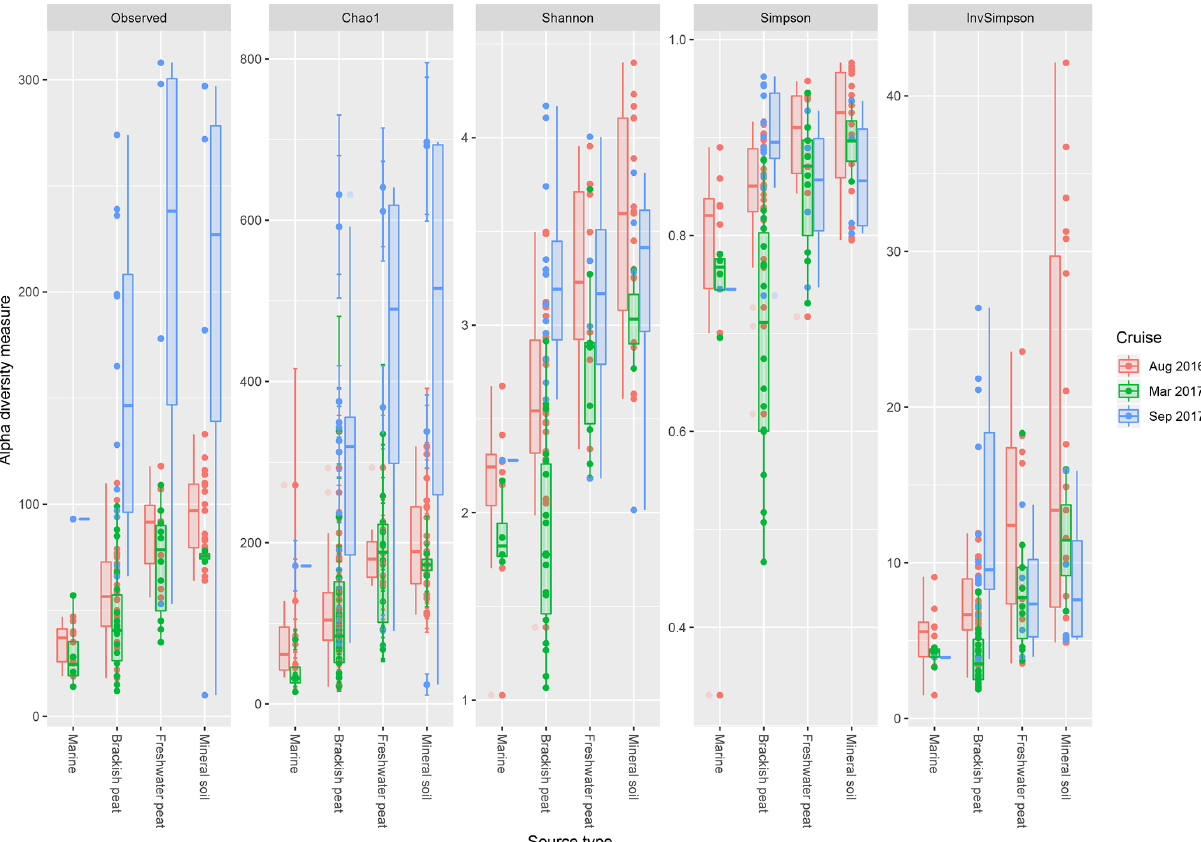
Figure 4. The calculated α -diversity indices (observed, Chao1, Shannon, Simpson and inverse Simpson) of the four different source type along the salinity